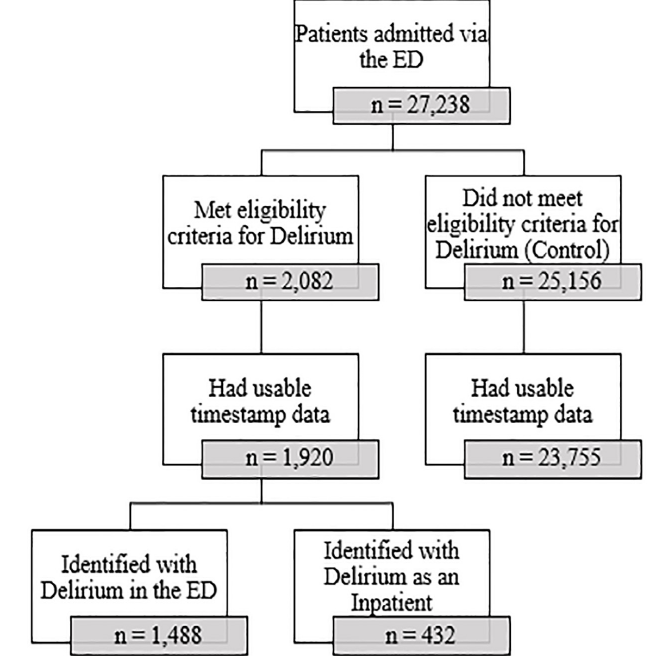
Figure 1. Patient flow diagram for study of association between delirium and emergency department (ED) site of care (data availability January 1–December 31,